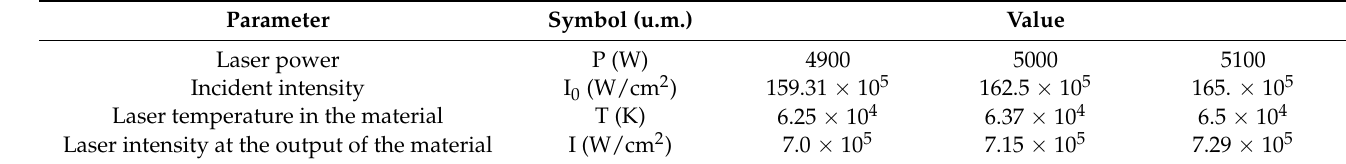
Table 6. Values of intensity and temperature depending on the laser output